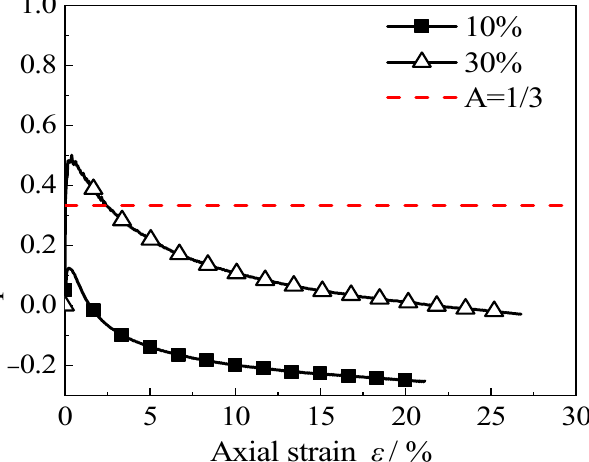
Figure 5. Variation curve of pore pressure coefficient A with the axial strain when C = 3.5 g/100 mL.